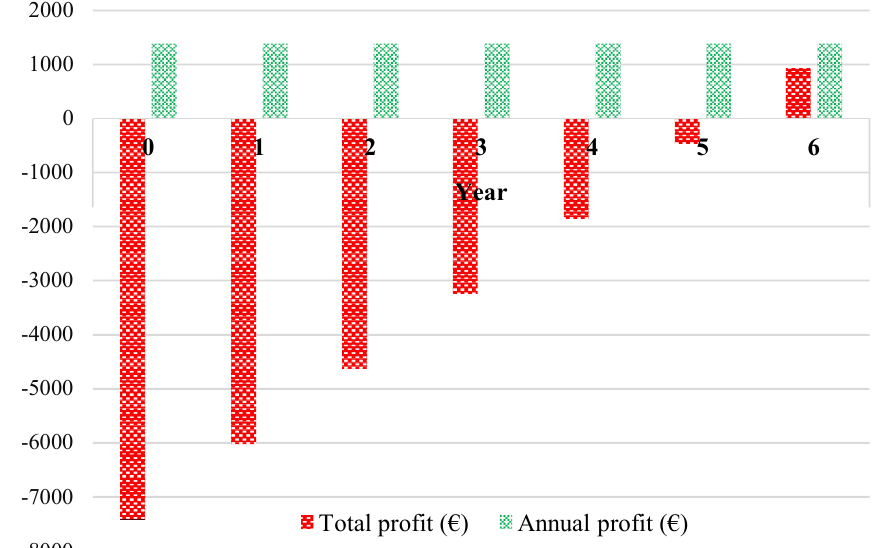
Figure 11. The total and annual earned profits.